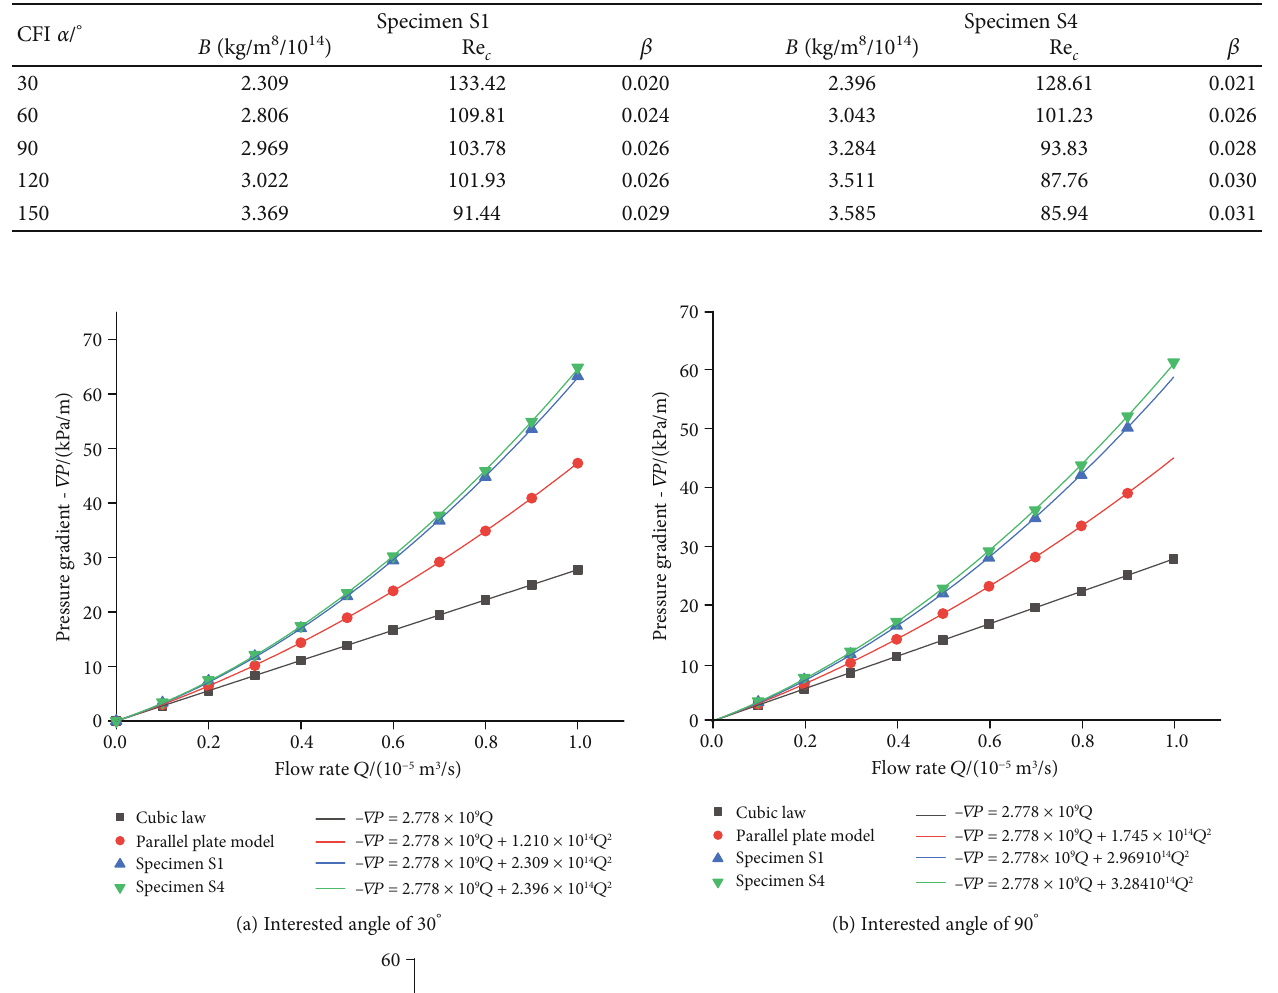
Table 4: The seepage parameters considering di ff erent intersected angles of rough fractures.